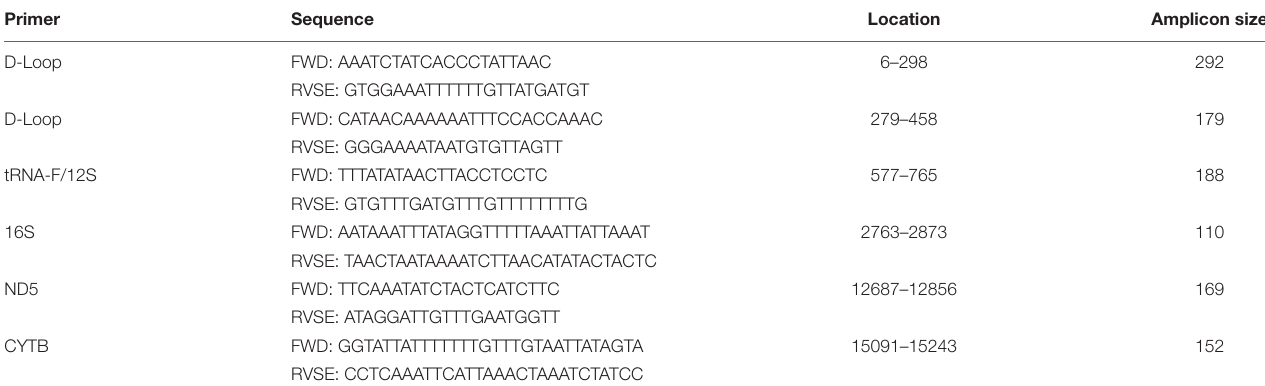
TABLE 1 | mtDNA primer sequences used for targeted bisulfite